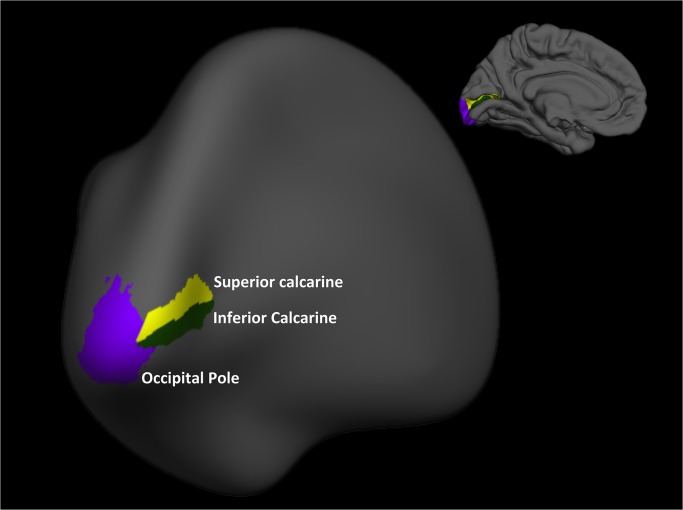
Freesurfer software segmentation of the visual cortex and regions of interest investigated: the occipital pole and the superior and inferior calcarine regions.